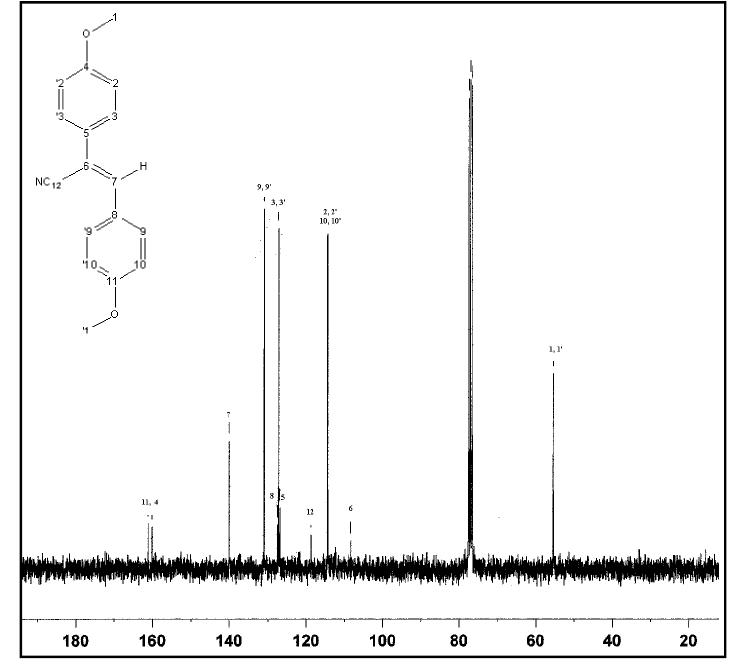
Figure 1. 13 C NMR spectra of BMPA .